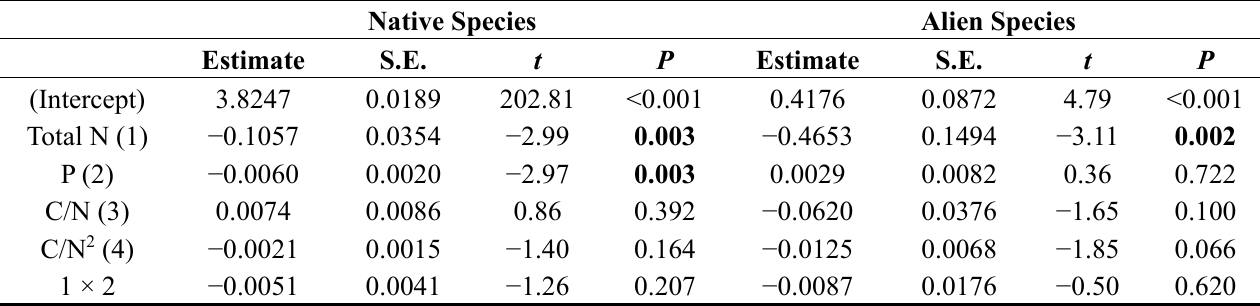
Table 3. Second order interactions models with the number of native and alien plants as response variables,